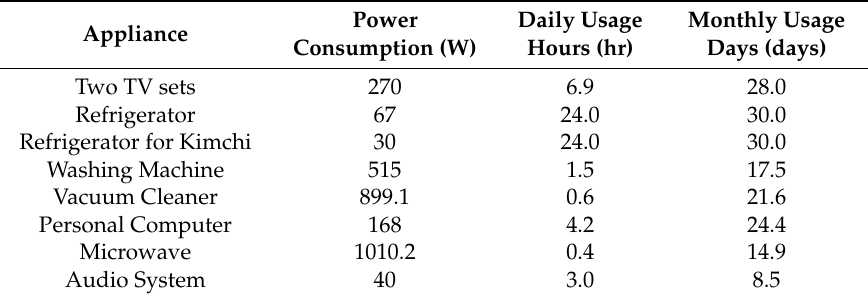
Table 2. Power consumption of general electrical appliances.